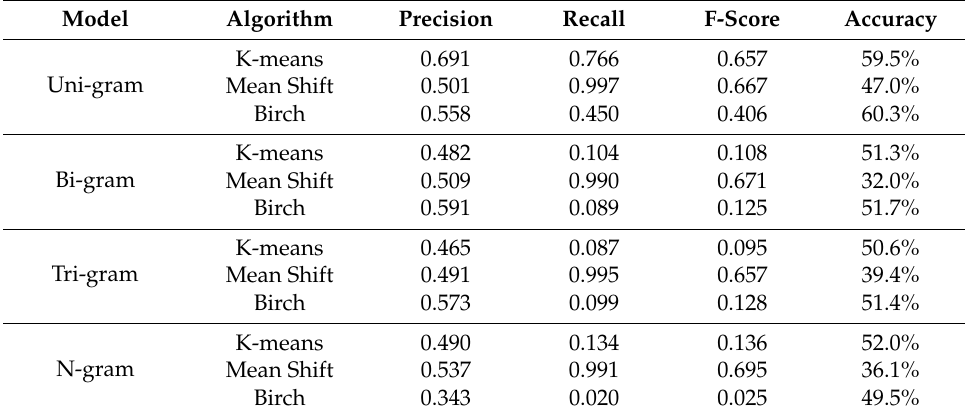
Table 11. Summary for clustering algorithms with n-gram model on the training